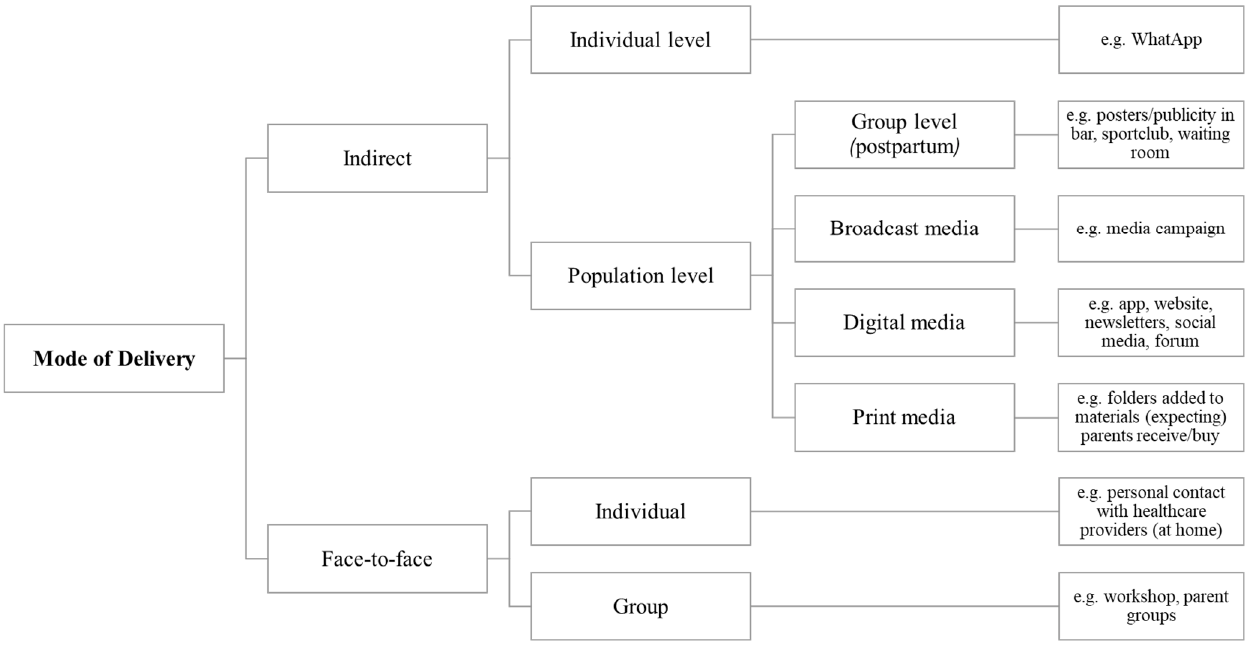
Figure 3. Mode of delivery and reachability of interventions targeting energy balance-related behavior in (expecting) parents.